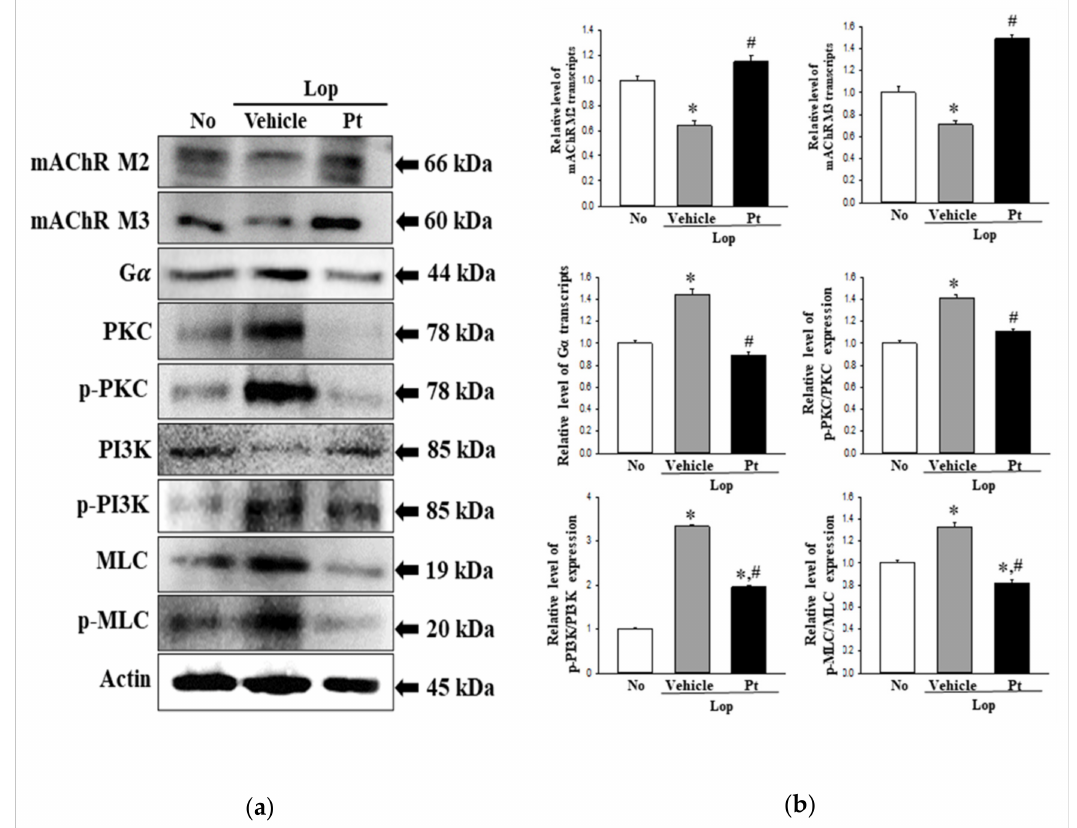
Figure 6. Expression of mAChRs and downstream signaling pathway. ( a ) Western blot image. ( b ) Relative levels of protein expression. After the preparation of mid-colon homogenates, the expression levels of nine proteins (mAChR M2, mAChR M3, G α , PKC, p-PKC, PI3K, p-PI3K, MLC, and p-MLC) were determined by Western blotting. After the determination of the intensity of each band, the expression of the nine proteins was determined as relative values to the intensity of actin as the endogenous control. A total of 4–6 SD rats were used in the preparation of total homogenates, and Western blots were assayed in duplicate. The data are reported as the mean ± SD. *, p < 0.05 compared to the non-treated (No) group. #, p < 0.05 compared to the Lop+Vehicle-treated group. Abbreviations: Lop, loperamide; Pt, phlorotannins; mAChR, muscarinic acetylcholine receptor; G α , G protein α ; PKC, protein kinase C; PI3K, phosphoinositide 3-kinases; MLC, myosin light